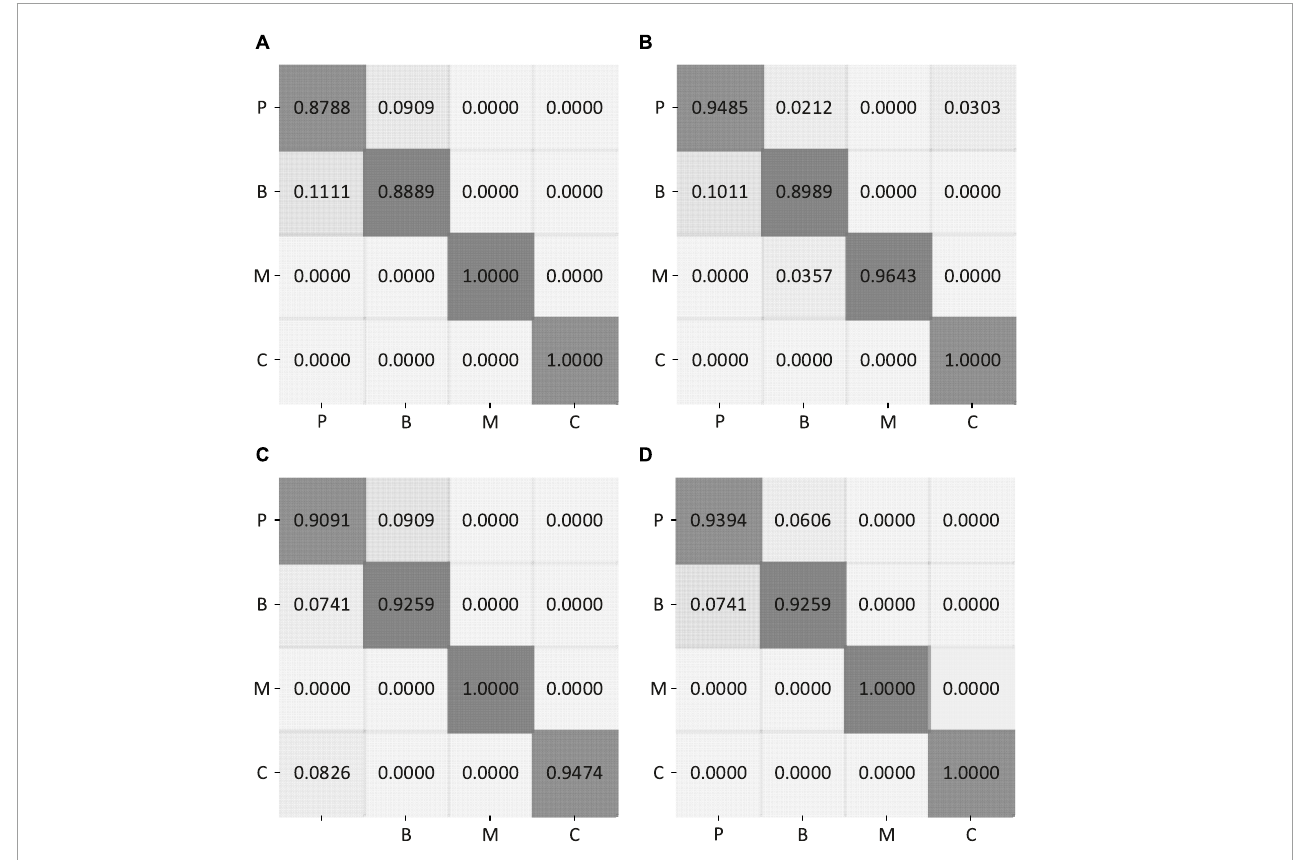
FIGURE9 Confusion matrices of four methods on CSI four-classification dataset. (A) CSI confusion matrix of FCN. (B) CSI confusion matrix of DeepWiTraffic. (C) CSI confusion matrix of ResNet. (D) CSI confusion matrix of ours. P, pedestrian; B, bicycle; M, motorcycle; C: car.